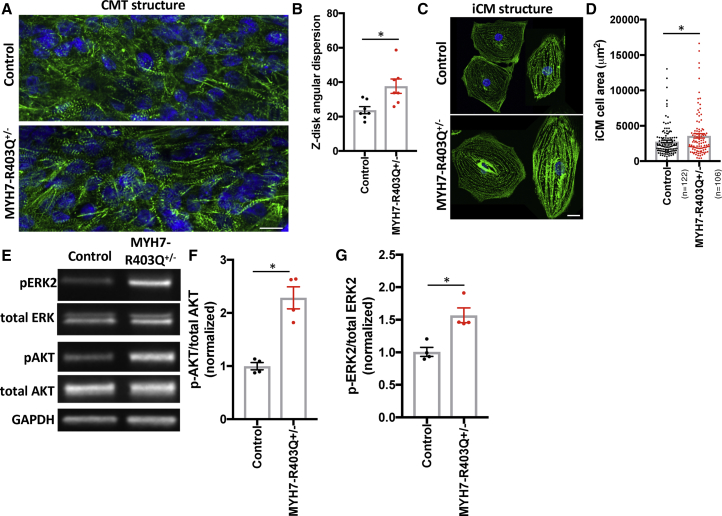
CMT and iCM Structural and Molecular Signaling Changes in MYH7-R403Q+/– Models(A) Representative confocal image of CMTs generated from MYH7-R403Q+/– and control iCMs and decorated with antibodies to cardiac alpha actinin (green) and co-stained with DAPI (blue). Scale bar, 10 μm.(B) Quantification of sarcomeric Z disk angular dispersion obtained from analysis of confocal regions of interest from CMTs decorated with antibodies to alpha actinin.(C) Representative confocal images of single MYH7-R403Q+/– and control iCMs decorated with antibodies to cardiac alpha actinin (green) and co-stained with DAPI (blue). Scale bar, 10 μm.(D) Quantification of MYH7-R403Q+/– and control iCM cell area from confocal images stained with alpha actinin.(E–G) Representative immunoblots from MYH7-R403Q+/– and control iCM lysates probed with antibodies to phospho- and total ERK (note: ERK2 is highly phosphorylated in iCM lysates) and phospho- and total AKT as well as GAPDH (loading control) (E). Normalized quantification of (F) phospho-AKT to total AKT and (G) phospho-ERK2 to total ERK2.Significance was assessed by Student's t test (B, D, F, and G) (∗all p < 0.05); data are means ± SEM (error bars) (B, D, F, and G). Each data point represents a single CMT (B), iCM (D), or sample generated from a batch of iCMs (F and G) generated by at least three biological replicates by iPS differentiation batch.